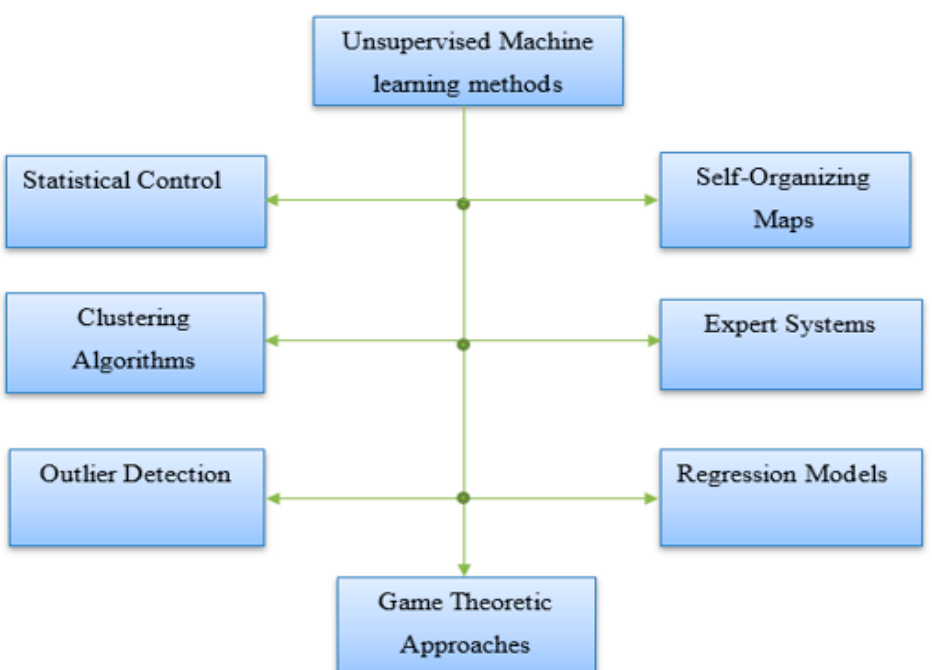
Figure 4. Unsupervised machine learning algorithms for NTL detection.